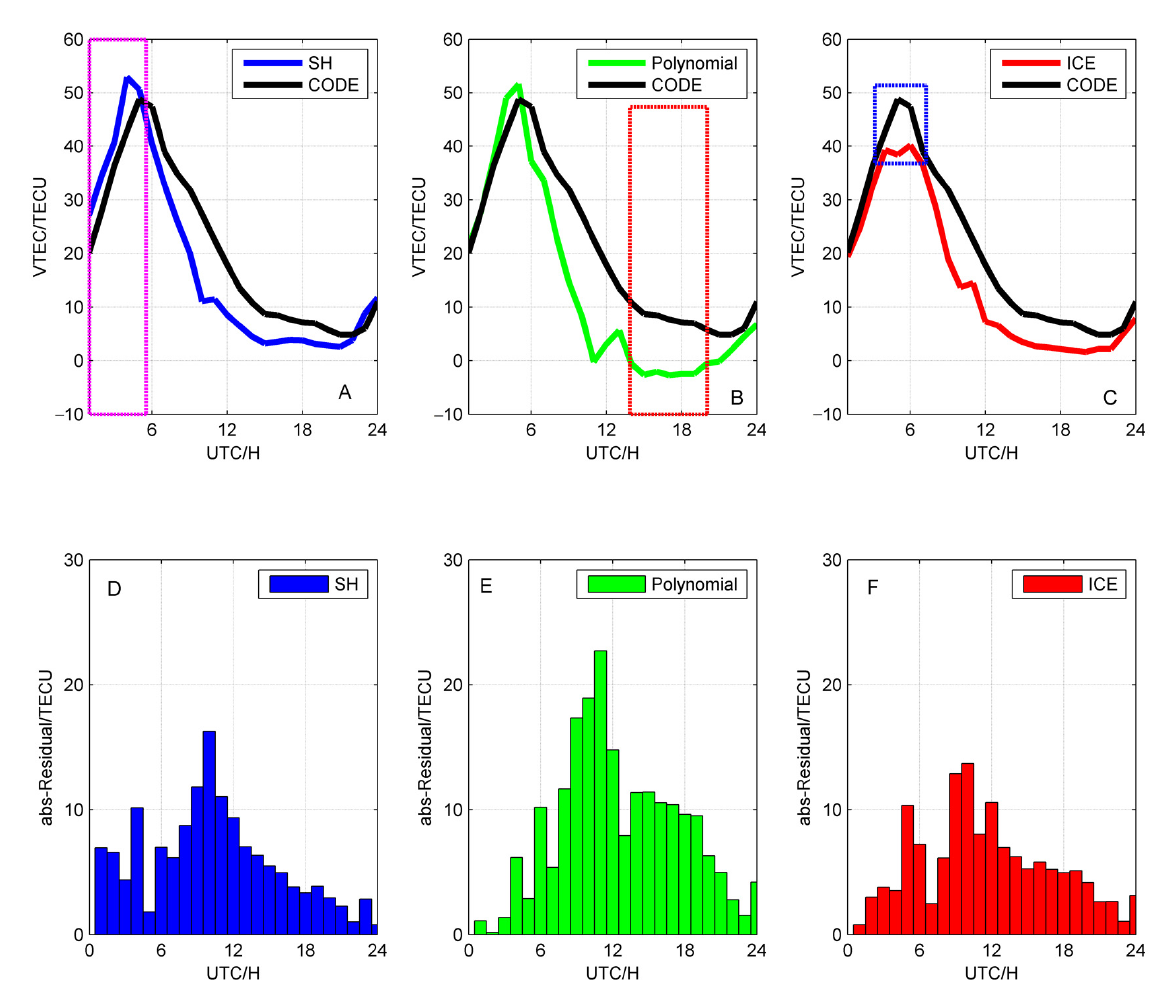
Figure 13. Performance analysis of three ionospheric models in low latitudes on the disturbance day. The blue, green, and red polylines show the time series of VTEC for SH (panel ( A )), polynomial (panel ( B )) and ICE (panel ( C )) models, respectively, and the black polyline is the time series of the refer-ence value. The blue (panel ( D )), green (panel ( E )) and red (panel ( F )) histograms are the absolute re-siduals for three models with respect to the reference value, respectively.